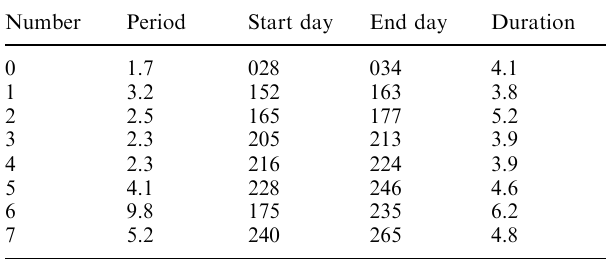
Table 2. Seven significant wave events observed over the South Pole with periods greater than 1 day between January 1995 and January 1996. All events are propagating eastward